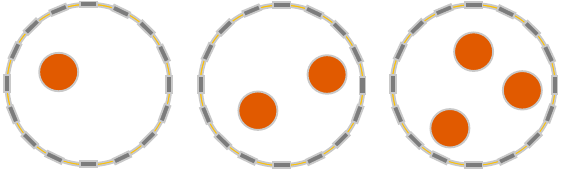
Figure 5. The different EIT configurations for the simulations.